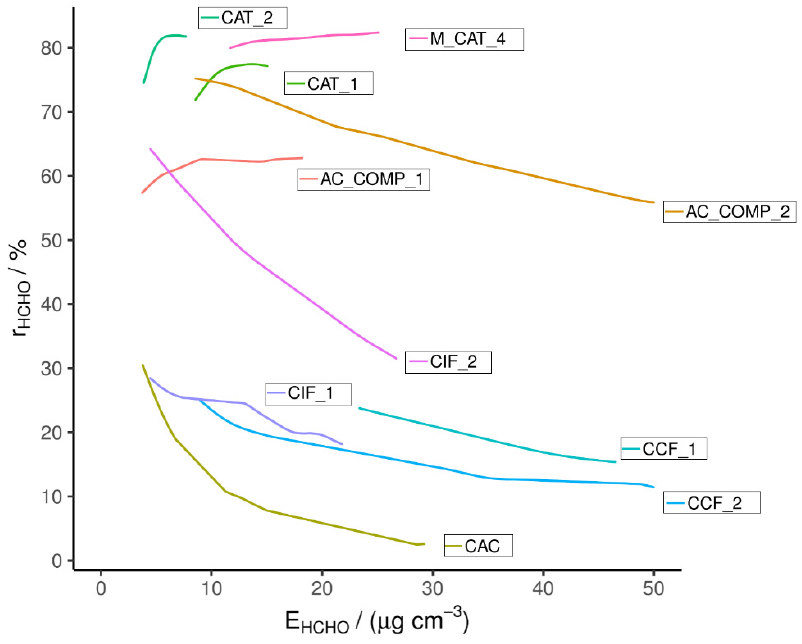
Figure 1. Single-pass HCHO removal e ffi ciency measured with the Figure 1. Single ‐ pass HCHO removal efficiency measured with the PTR ‐ MS.